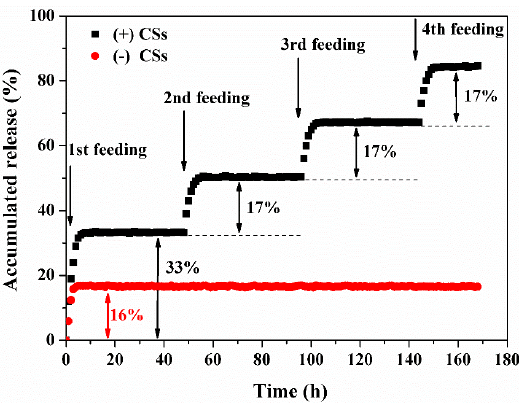
11 of 15 Figure 6. ( A ) Effect of molar ratio of CS15 to aptamers on thrombin release. The concentration of aptamer is fixed at 200 μ M (the volume is 1 μ L). The total release time was 6 h. Here, CSs:aptamer = 0 was represented as the control group. The experimental group with significantly higher cumulative release than the control group is noted with *, ( p < 0.05). ( B ) Effect of lengths of CSs on the release amount of thrombin. The normalized release of TB triggered by CSs (bp 0) is regarded as 1. The normalized release with obviously more than the CS (bp 0) is noted with *, ( p < 0.05). ( C ) Profiles of thrombin wise-stage release in the release medium regulated with or without CS15 at different triggering times (0 h and 12 h). 3.5. Application in Complex Matrixes A complex matrix, human serum, was investigated for the practical application of the hydrogel in the triggered release of thrombin. The hydrogel that captured the thrombin was immersed in the human serum solution. The serum solution had been diluted 50 times before each experiment. Then,